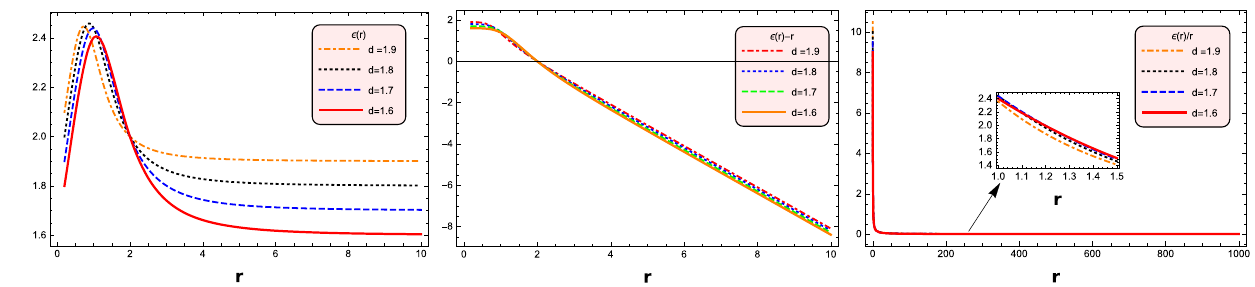
Fig. 1 Evaluation of wormhole shape function (cid:3)( r ) (1st plot) and its required conditions (cid:3)( r ) − r = 0 at r = r 0 (2nd plot), (cid:3)( r ) (3rd plot) for r 0 = 2 and C = 1 . 9 to present the realistic wormhole geometry